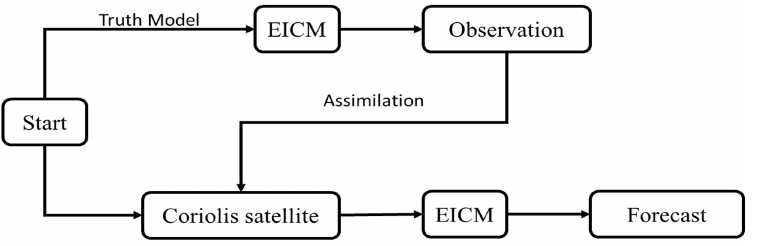
Figure 2. Ensemble Intermediate Coupled Model (EICM) Data Assimilation with an operational assimilation working